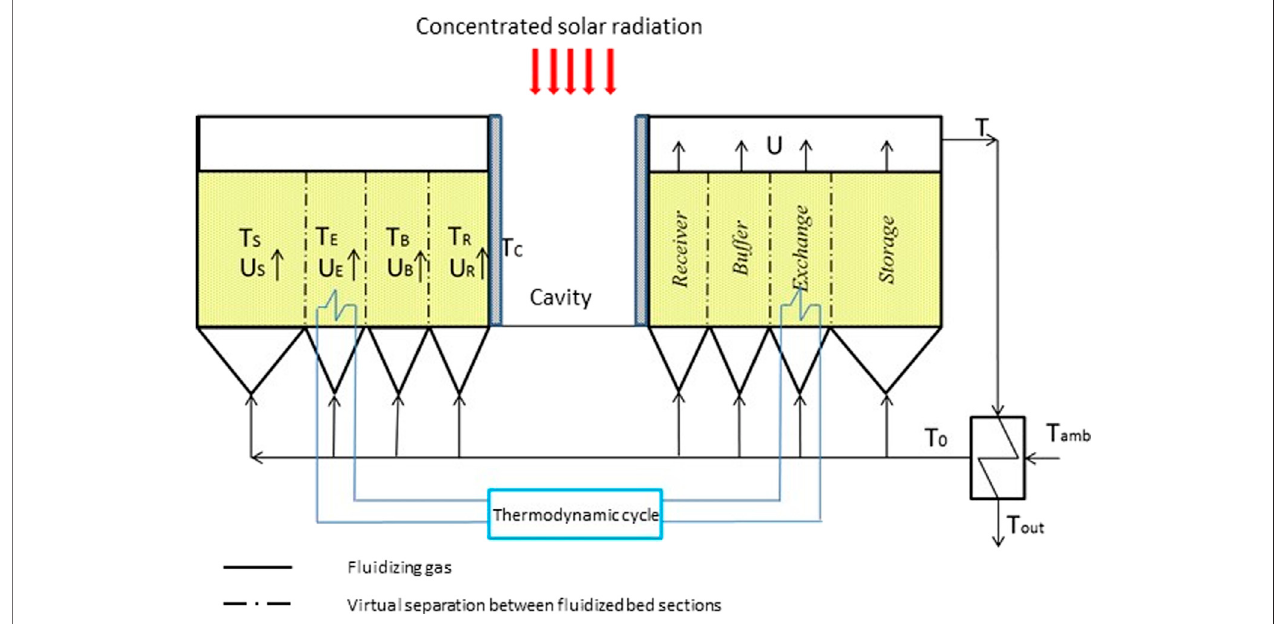
FIGURE 3 | Conceptual representation of the solar receiver/thermal energy storage system based on compartmented dense gas fl uidized beds (adapted from Solimene et al. (2017), with the permission of AIP Publishing).